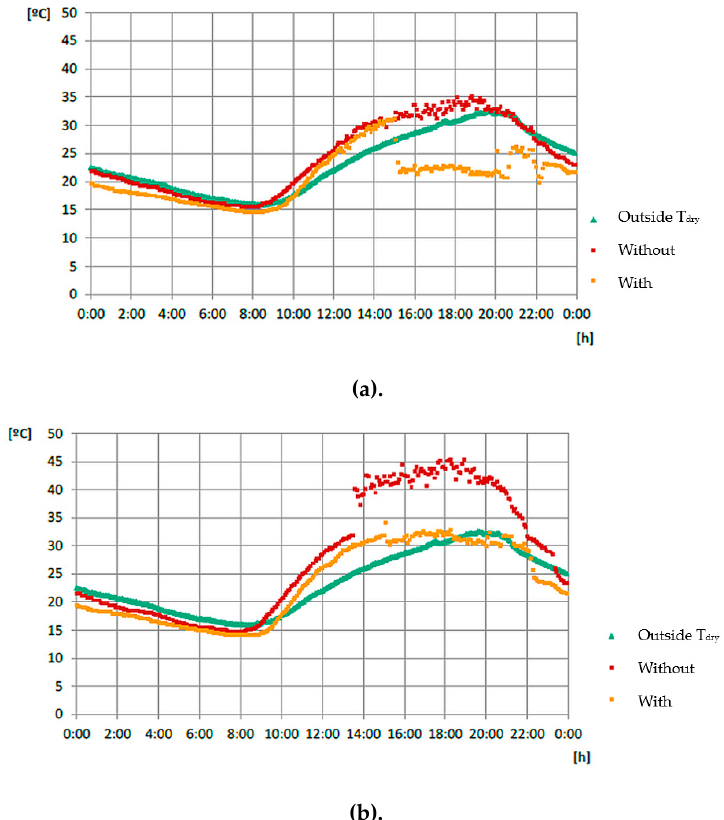
Figure 7. ( a ) Inlet air temperature and ( b ) condensation temperature “with” and “without” evaporative cooling pad.